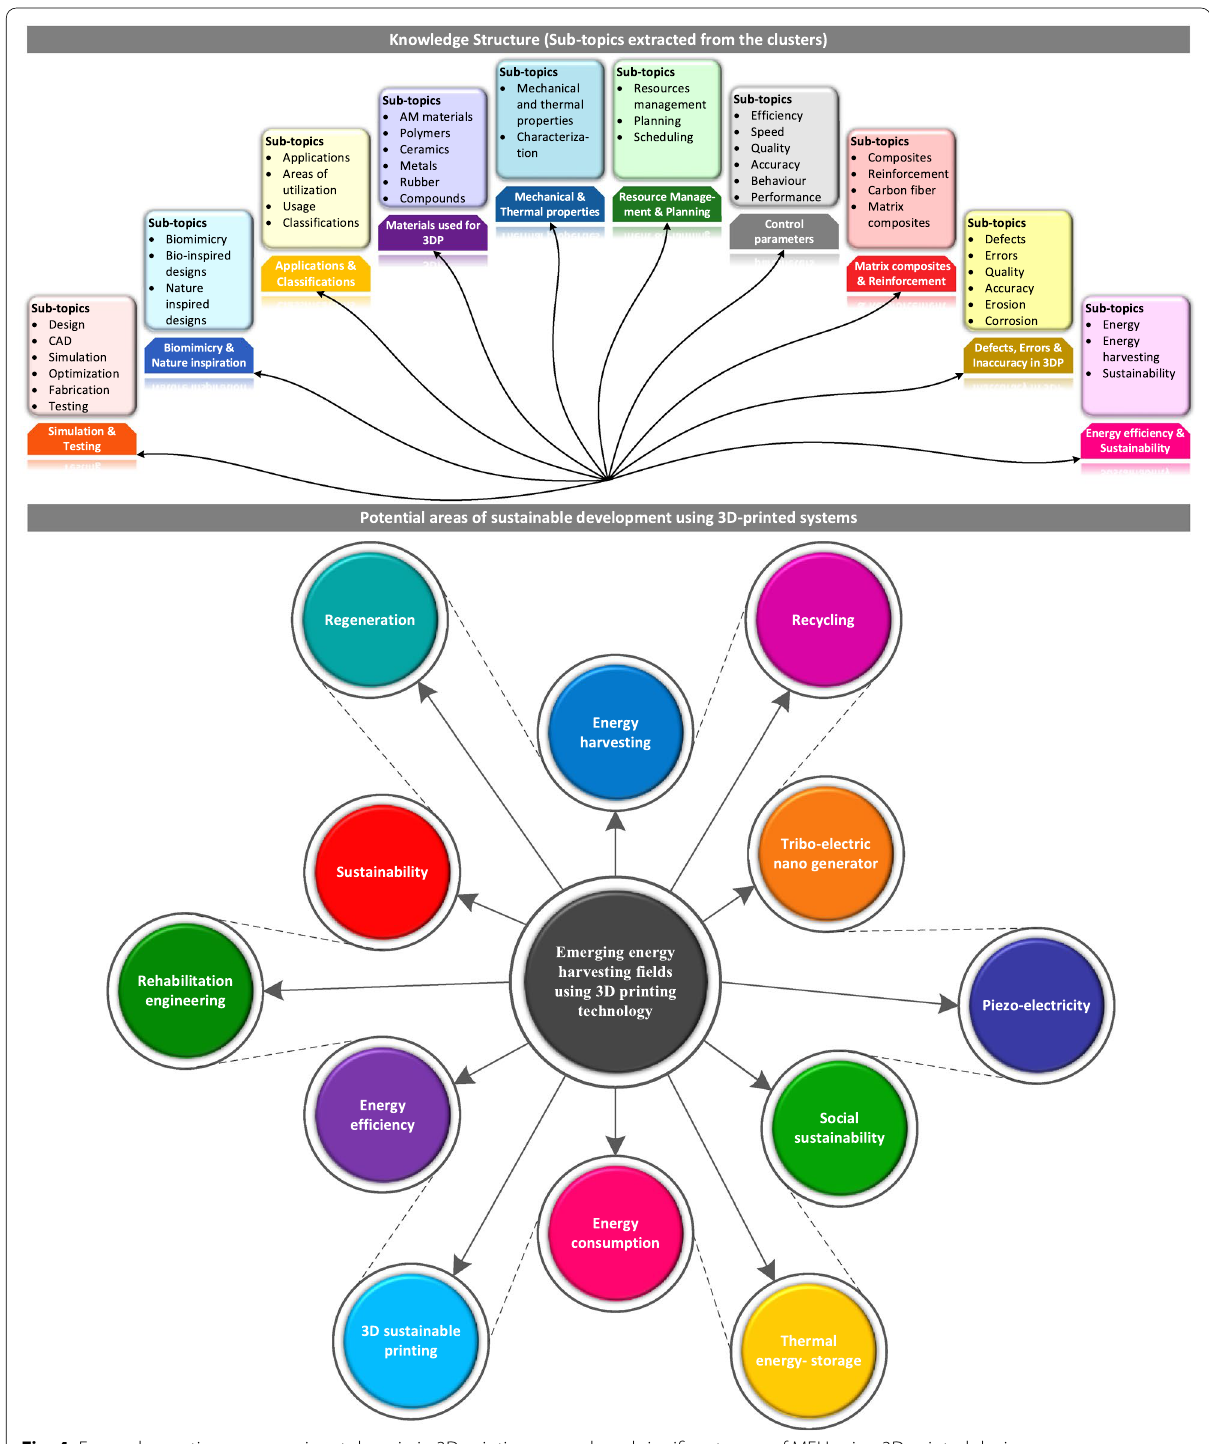
Fig. 4 Energy harvesting as a prominent domain in 3D-printing research and significant areas of MEH using 3D-printed